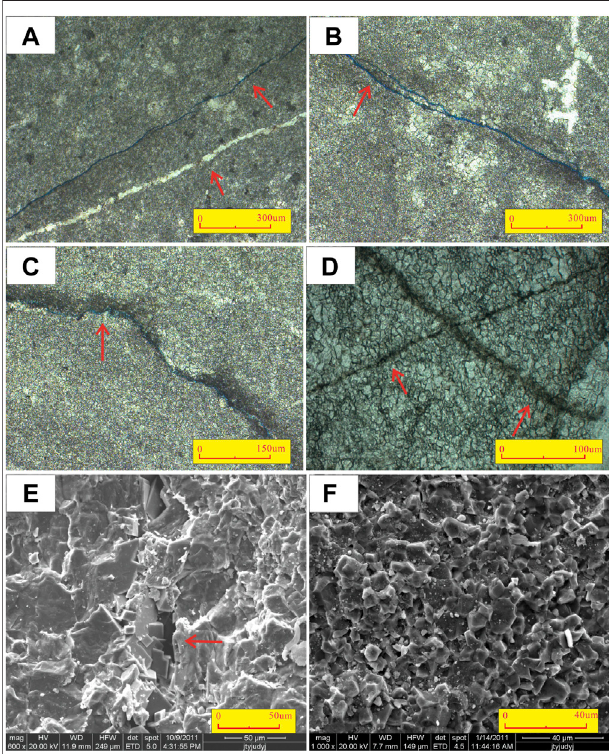
FIGURE 4 | Fracture development characteristics from cast thin sections and SEM in the Sandaoqiao gas fi eld. (A) , well Q1, Z, 5,741.4 m, argillaceous dolomite; 3% continental debris, 1% siliceous, and 1% muscovite. Three microcracks were fi lled with siliceous material and 1 microcrack was fi lled with dolomite. (B) , well Q1, Z, 5,754.8 m, silty argillaceous dolomite, 2% siliceous, and 1% muscovite. The face rate is less than1%.Onemicrocrackwithawidthof0.01 mm. (C) ,wellQ1,Z,5,756.1 m, silty argillaceous dolomite, 2% siliceous, and 1% muscovite. The face rate is less than 1%. One straight microcrack with a width less than 0.01 mm; one microcrack along the suture, with a width less than 0.01 mm; (D) , well Q101, ∈ , 5,821.5 m, the dolomite grains are 0.04 – 0.10 mm, granular and inlaid. Microcracksaredeveloped.Dolomite; (E) ,wellQ101, ∈ ,5,822.2 m,dolomite- fi lled fractures, part of which have clay on the surfaces, dolomite with poor crystallization, generally semi-automorphic-heteromorphic; (F) , well Q1, Z,5,741.4 m, gray micrite dolomite, argillaceous dolomite, dolomite with poor crystallization, generally